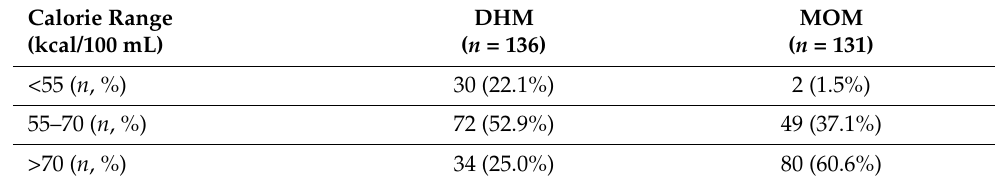
Table 1. Distribution of human milk samples as low, expected, or high-calorie ranges. Calorie